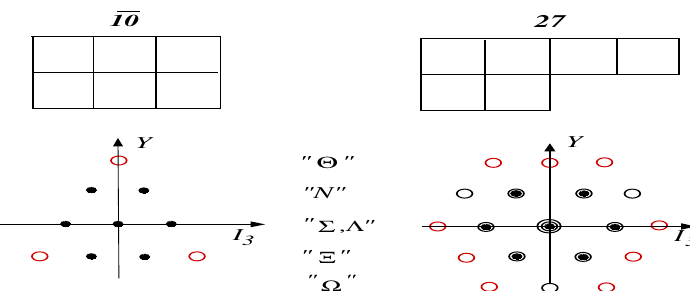
Figure 2. (Color online) Young tableaux and particle content the anti-decuplet and the 27-plet SU ( 3 ) representations. Red circles indicate exotic baryons that cannot be built from three